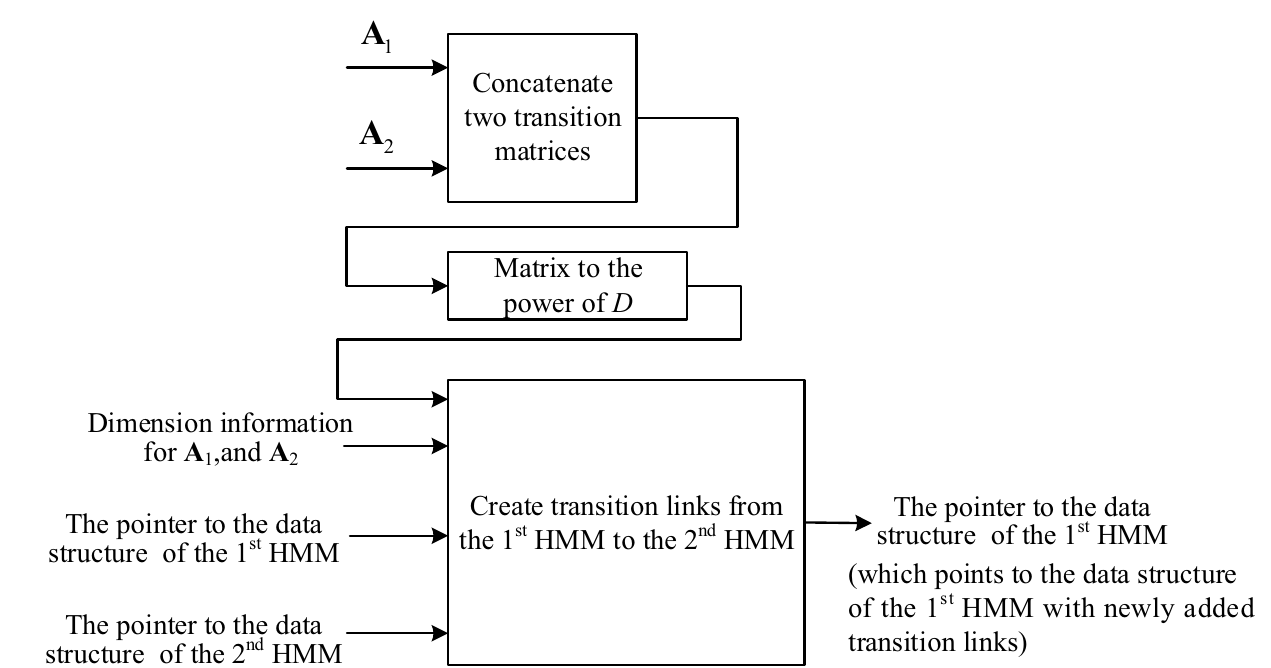
Fig 9. Creation of transition links from the 1 st HMM to the 2 nd HMM for frame-rate reduction factor D using the connecting-then-adapting approach.